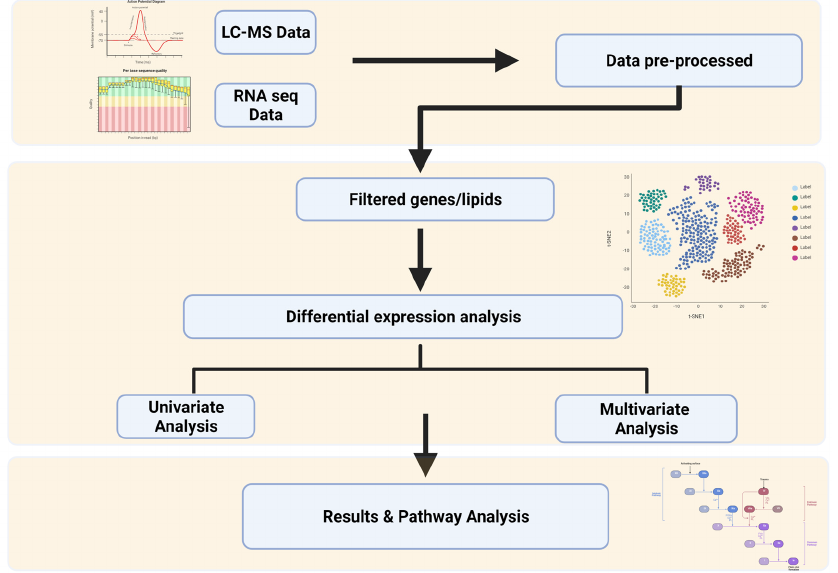
Figure 1. (Created with BioRender.com) NAFLD biomarkers identification study design consisting of pre-processing step followed by differential expression analysis for feature selection and then univariate and multivariate analysis. The final step includes the results interpretation and pathway